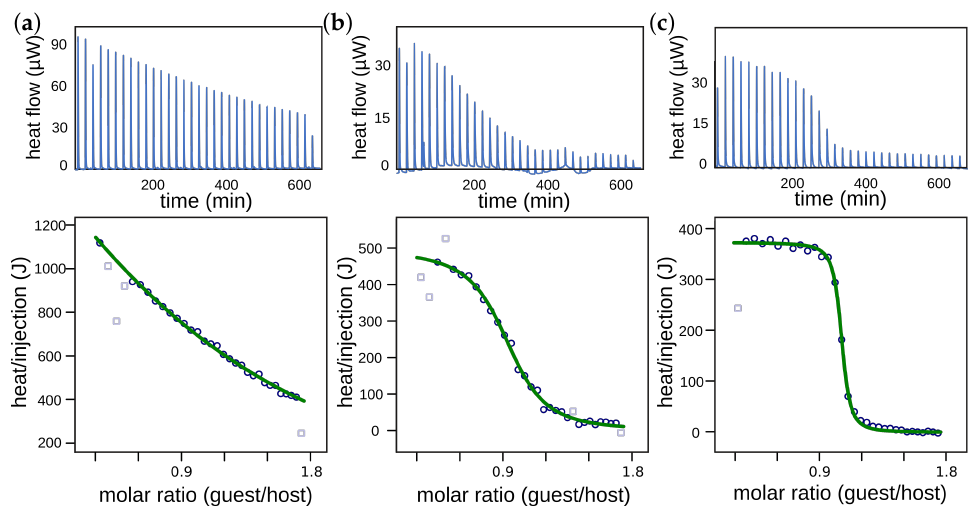
Figure 6. Titration plots (heat flow versus time and heat/volume versus guest/host ratio) obtained from ITC experiments at 298 K in 1,2-dichloroethane: ( a ) vial: TTFC8 , syringe: A1 -BF 4 ; ( b ) vial: TTFC8 , syringe: A1 -NTf 2 ; ( c ) vial: TTFC8 , syringe: A1 -pf. Points marked with non-filled squares were not considered in the fitting process.